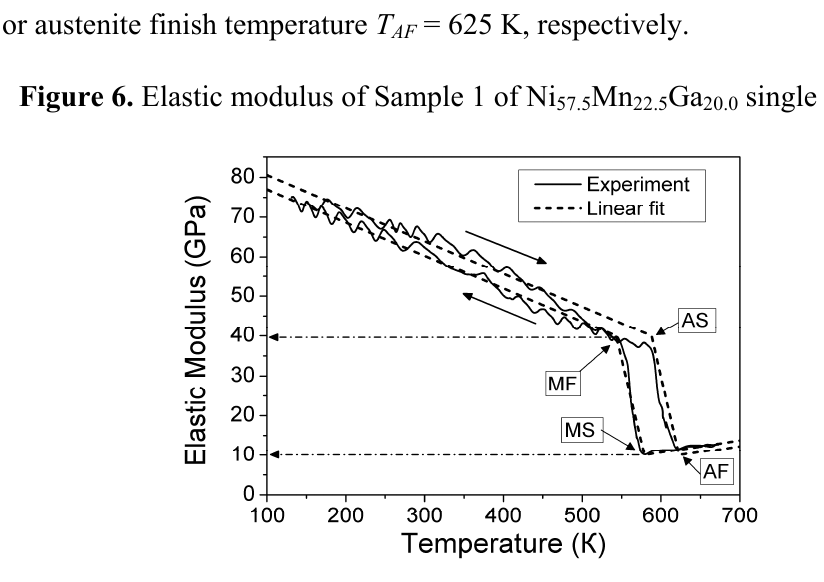
Figure 6. Elastic modulus of Sample 1 of Ni